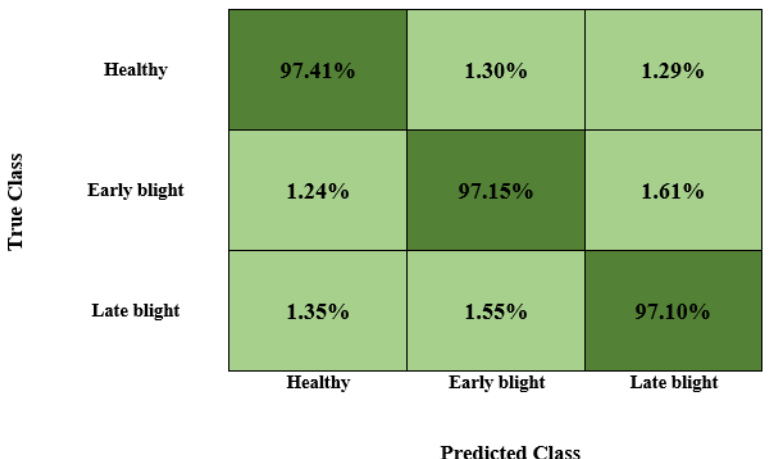
Figure 9 . Attained results in the form of a confusion matrix .